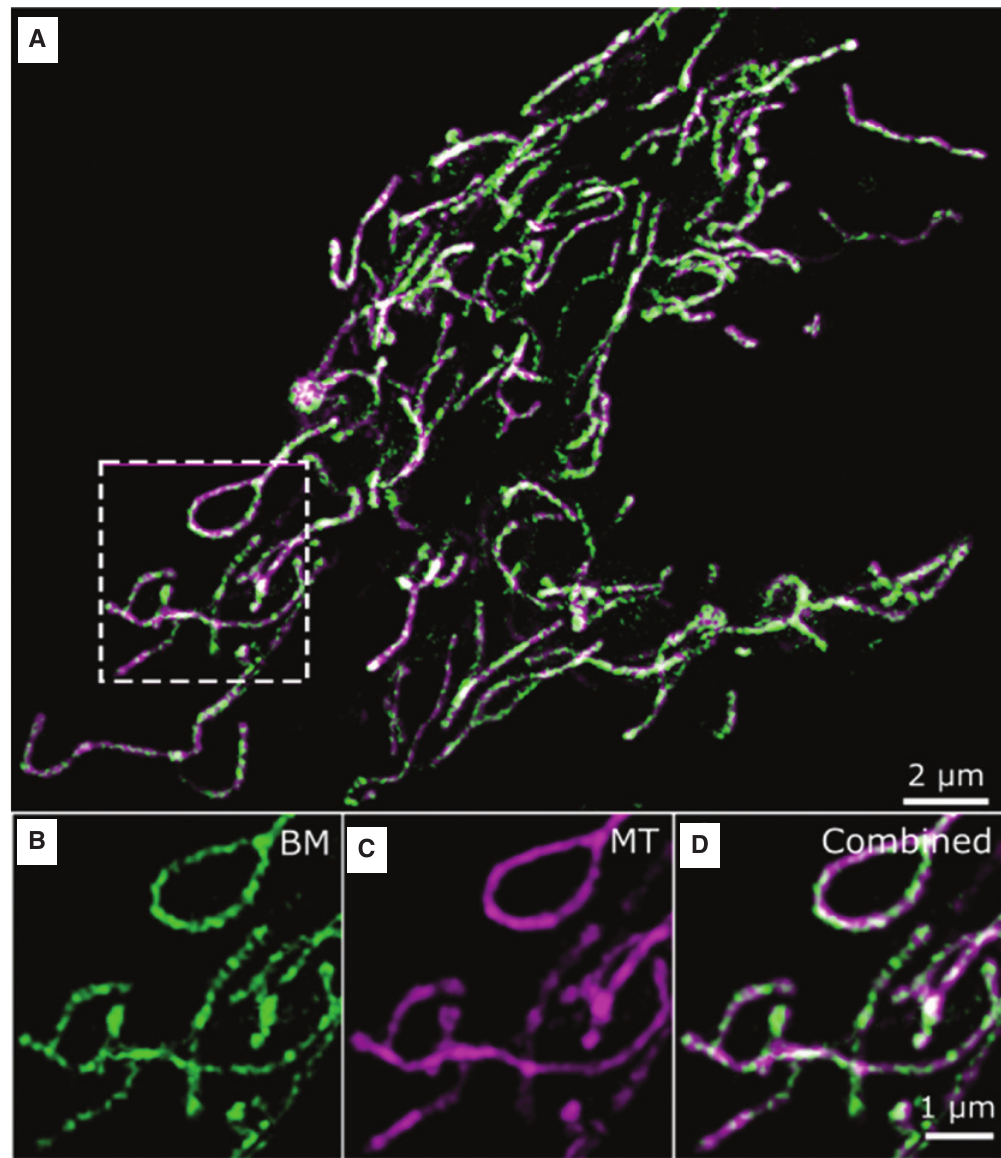
Figure 4: Live imaging of an MCC13 cell dually labeled with BM and MT. The boxed region in (A) is shown magnified for the individual (B and C) and combined probes (D). For cells with low levels of BM expression, the same concentration of MT could be used as was optimized in MT-alone experiments (100 nm), but the low BM signal compromises image quality (B). Sub-mitochondrial localization cannot be determined in these samples, as the structure of cristae (which had been observable using MT alone) are no longer discernable in the MT channel (C). Images are maximum intensity projections of a 1- μ m 3D SIM